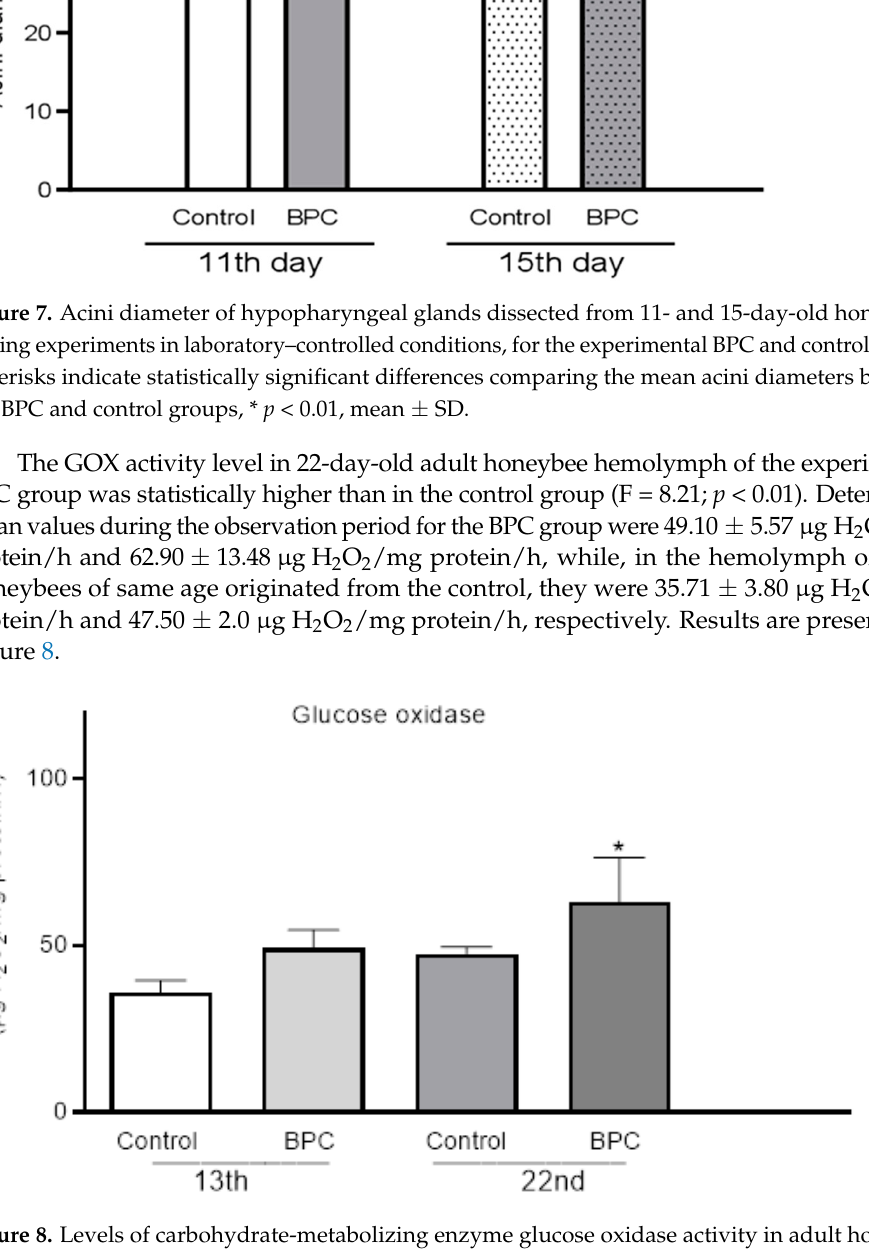
Figure 8. Levels of carbohydrate-metabolizing enzyme glucose oxidase activity in adult honeybee hemolymph sampled on the 13th and 22nd day of the experiment under laboratory-controlled conditions for experimental the BPC and control groups. Asterisks indicate statistically significant differences: BPC vs. Control, * p < 0.01, mean ± SD.